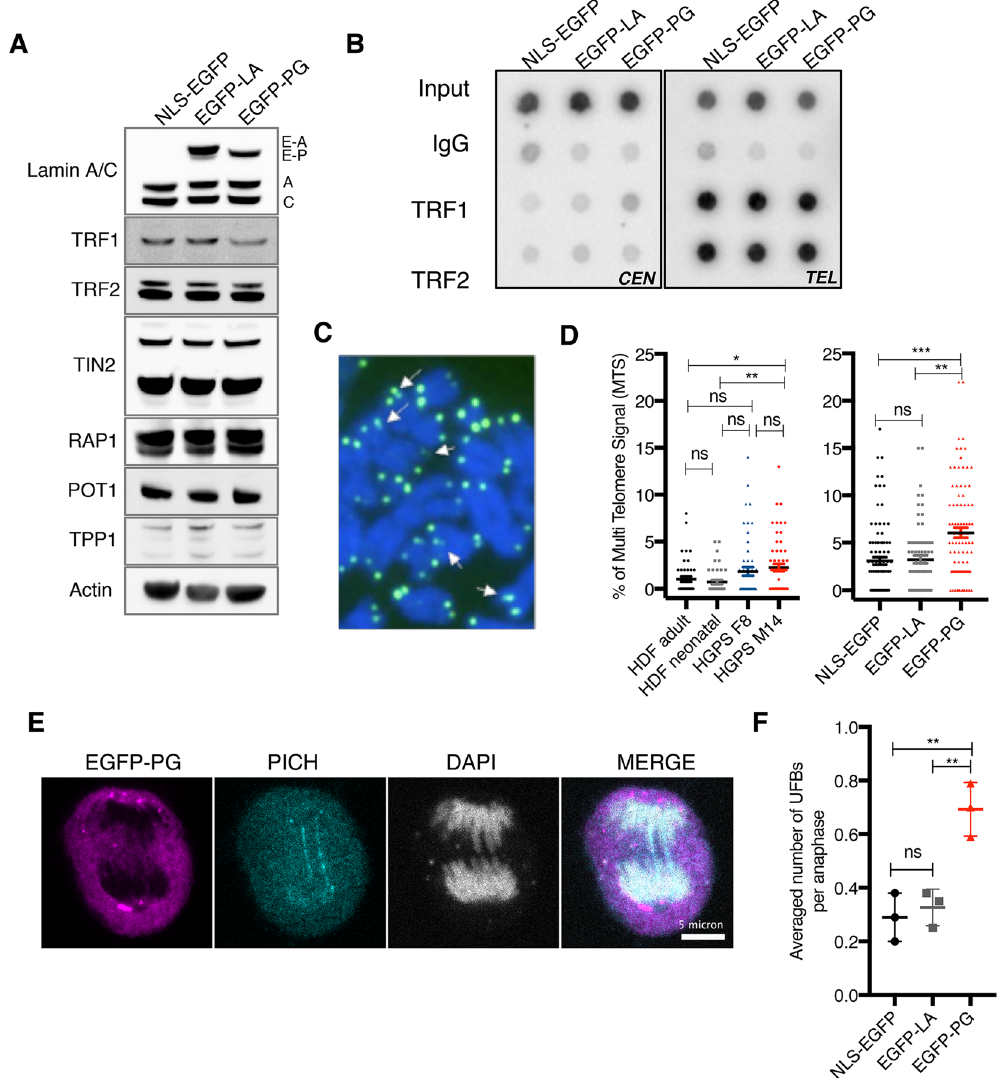
Figure 3. Progerin challenges telomere replication. ( A ) Western blots of whole cell extracts of the indicated cell lines. Antibodies used are indicated. A representative actin loading control is shown. ( B ) Representative ChIP- dot blot on HDF cells expressing NLS-EGFP, EGFP-LA or EGFP-PG. Immunoprecipitations were performed with the indicated antibodies and dot blots hybridized with telomere (TEL) or centromere (CEN)-specific probes. ( C ) Representative image of a metaphase spread from HDF cells expressing EGFP-PG. Telomeric DNA is visualized with a PNA probe (FITC) and DNA is stained with DAPI. Arrows point to chromosome ends with Multiple Telomere Signal (MTS). ( D ) Quantification of MTS in HGPS cells and controls (left) or HDF expressing the indicated constructs (right). The graphs represent the percentage of MTS per metaphase ± SD (n = 3). A total of 73 to 94 metaphases were scored in HDF cells, and between 42 and 58 metaphases in HGPS cells. Statistical significance was determined using Mann Whitney test (*indicates p < 0.05, and **p < 0.005). ( E ) Representative immunostaining of HDF cells expressing EGFP-PG. EGFP signal (purple), PICH (cyan), and DAPI (grey). Scale bar: 5 μm. ( F ) Quantification of PICH immunostaining as in C for HDF cells expressing NLS-EGFP, EGFP-LA, EGFP-PG. The graph represents the average number of ultra-fine bridges (UFBs) per anaphase in the indicated cell lines (with SD). Statistical significance was determined using unpaired t-test, n = 3 (**indicates p <